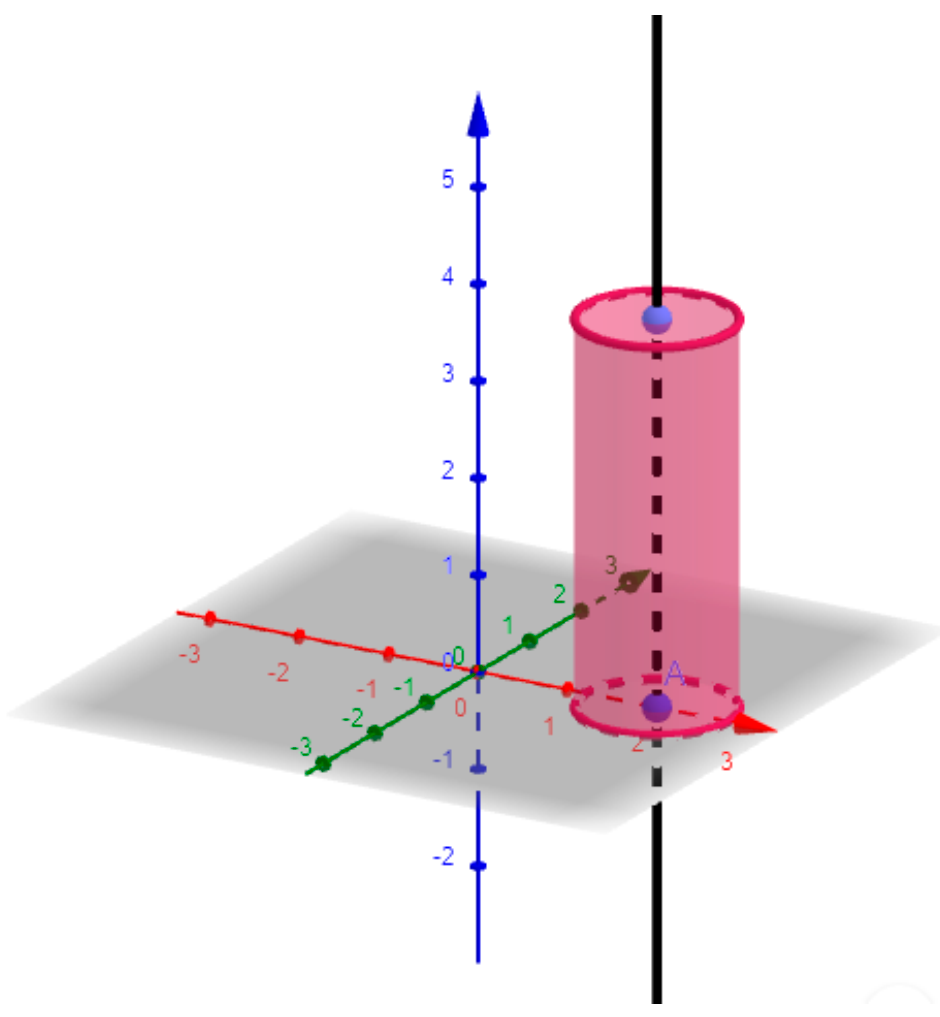
Figure 1. Representation of a cylinder in the dynamic software GeoGebra.